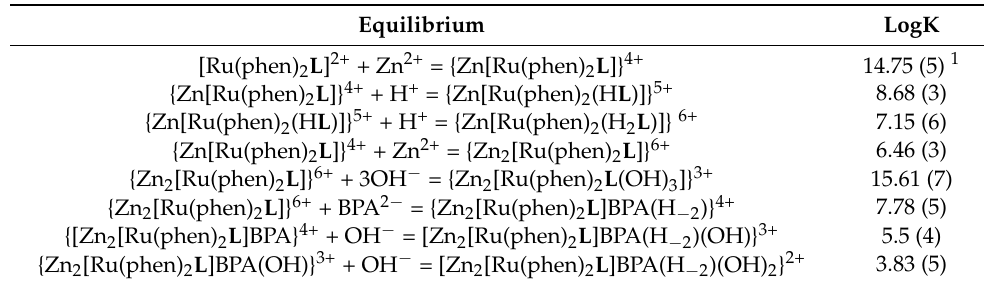
Table 2. Formation constants of the Zn II complexes with [Ru(phen) 2 L ] 2+ and of their adducts with deprotonated BPA (indicated with BPA(H − 2 )).